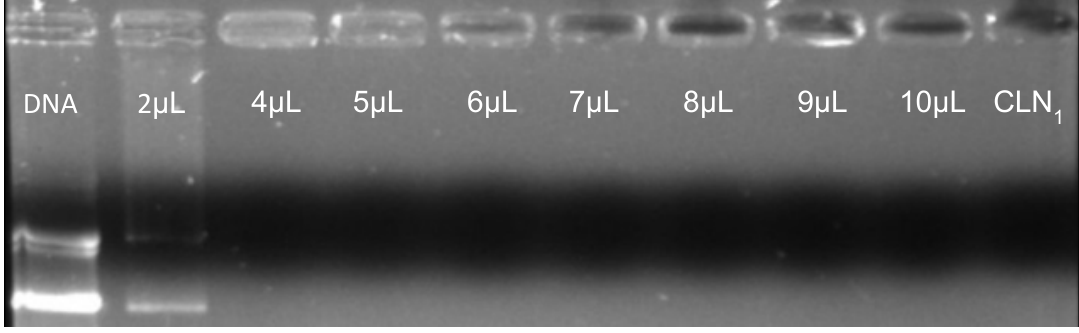
Figure 1. Influence of the CLN